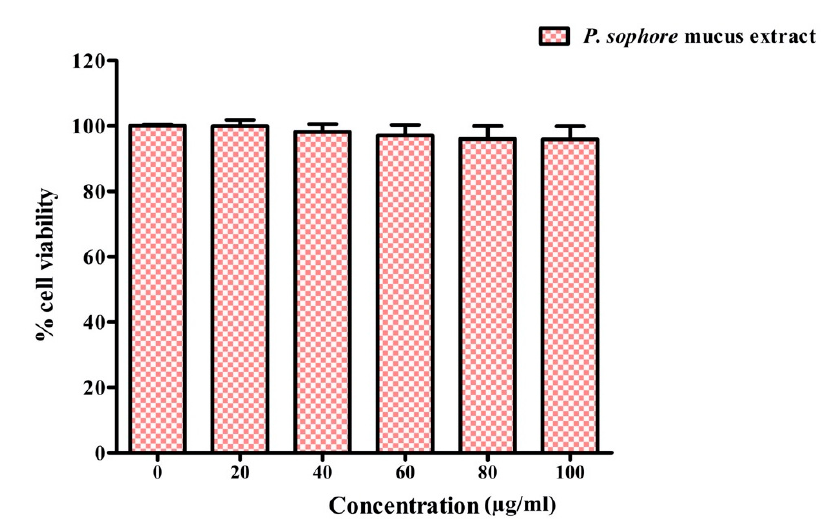
Figure 9. Cytotoxicity of P. sophore mucus extract on CRL-1831 cells. All experiments were carried out in triplicate, and data represent the mean ± SEM.